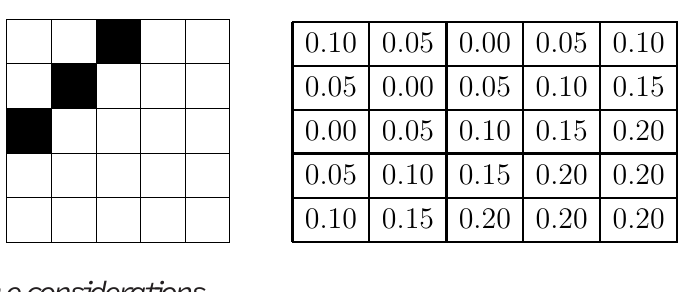
Figure 3. Cartoon image and δ